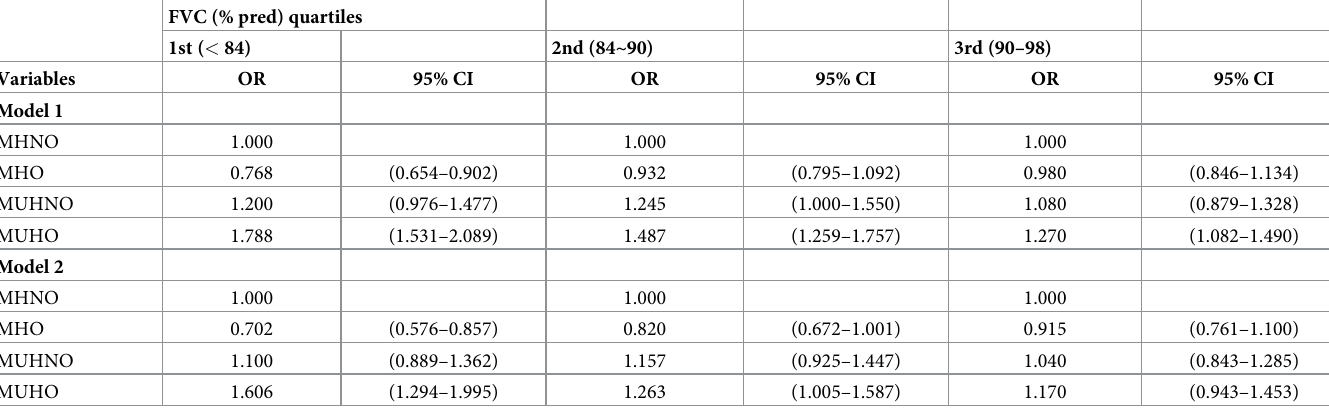
Table 4. Odds ratio for decreased lung function and metabolic health status according to quartiles of FVC % of predicted value.